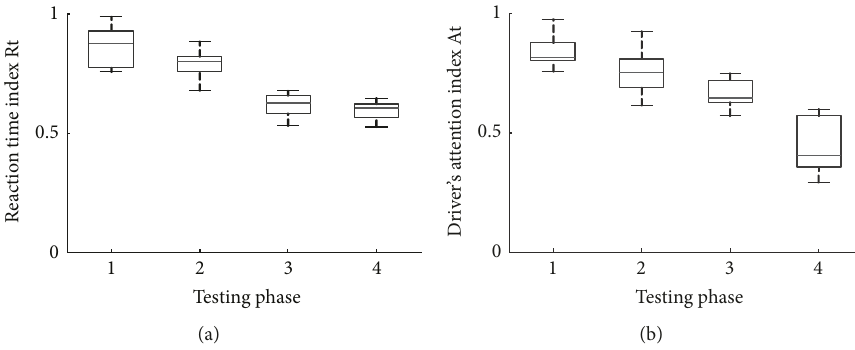
Figure 4: Response time and attention indicators in different driving stages of the statistical box